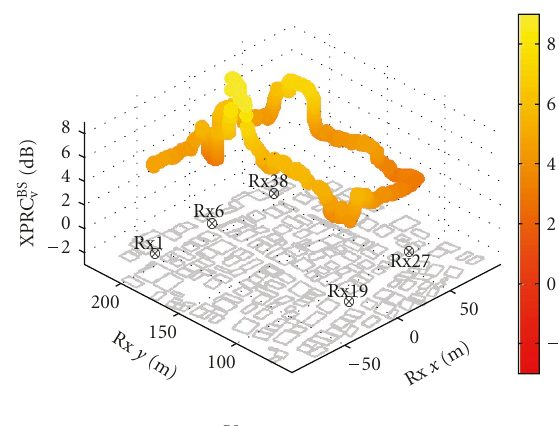
Figure 30: XPRC MS